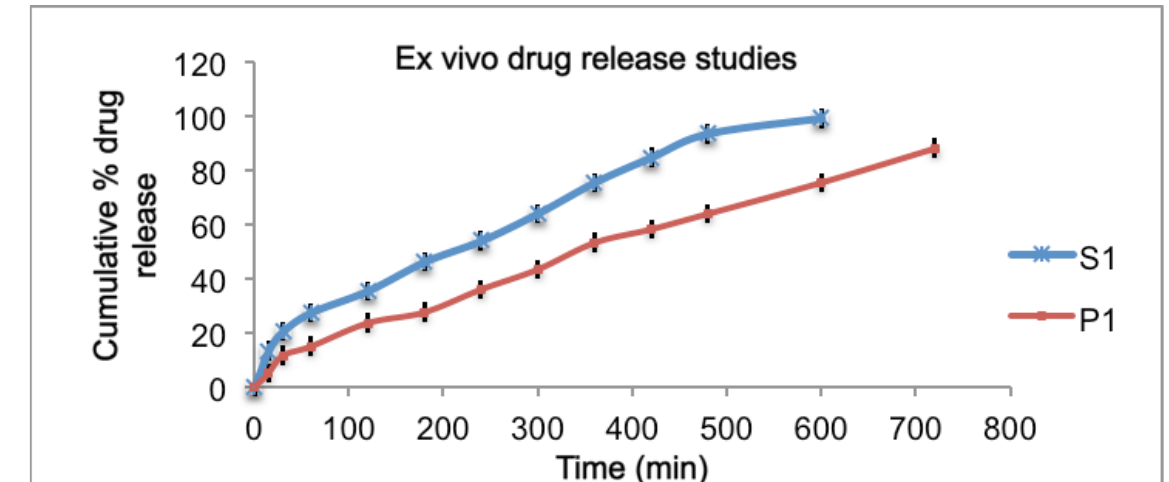
FIGURE 11 - Ex vivo drug release profile of formulation S1 and P1 through pig membrane.